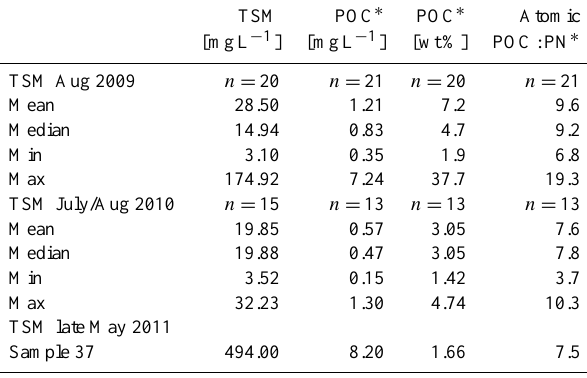
Table 2. Total suspended matter (TSM) concentrations in Lena Delta surface waters (2009 to 2011) and atomic particulate organic carbon (POC) to particulate total nitrogen (PN) ratios. Note that for August 2009 there are only n = 20 samples for TSM (mgL − 1 ) and POC (wt%), because the GF/F filter weight of sample 19 was not determined. The atomic POC:PN ratio of sample 19 was therefore calculated based on the filtered water volume (POC in mgL − 1 ).